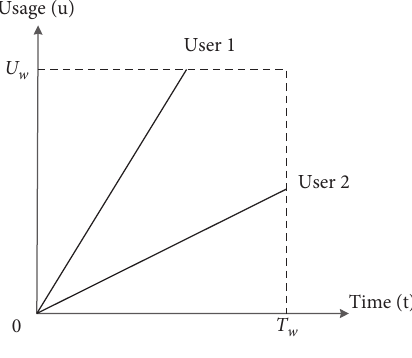
Figure 1: 2D warranty